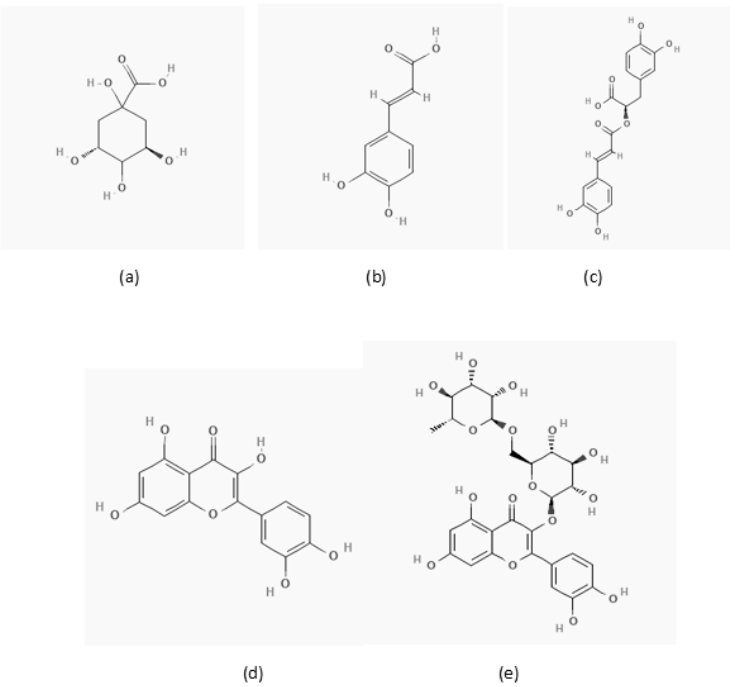
Figure 1. Molecular structures of the compounds tested: caffeic acid ( a ), quinic acid ( b ), rosmarinic acid ( c ), quercetin ( d ), and rutin ( e ).